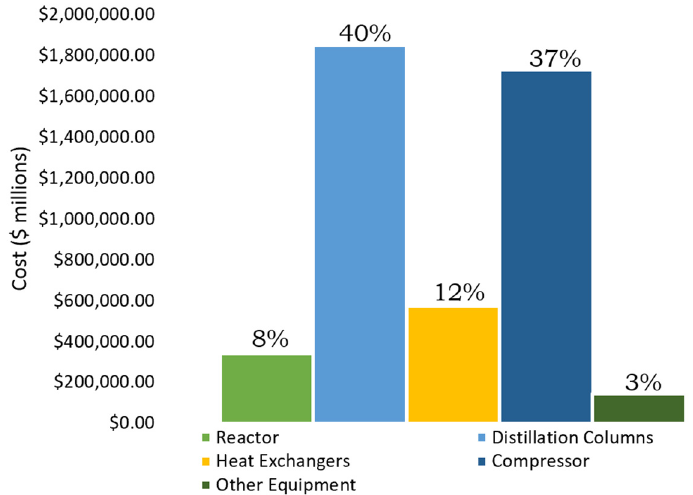
Figure 5. Fixed capital cost distribution for the developed process.